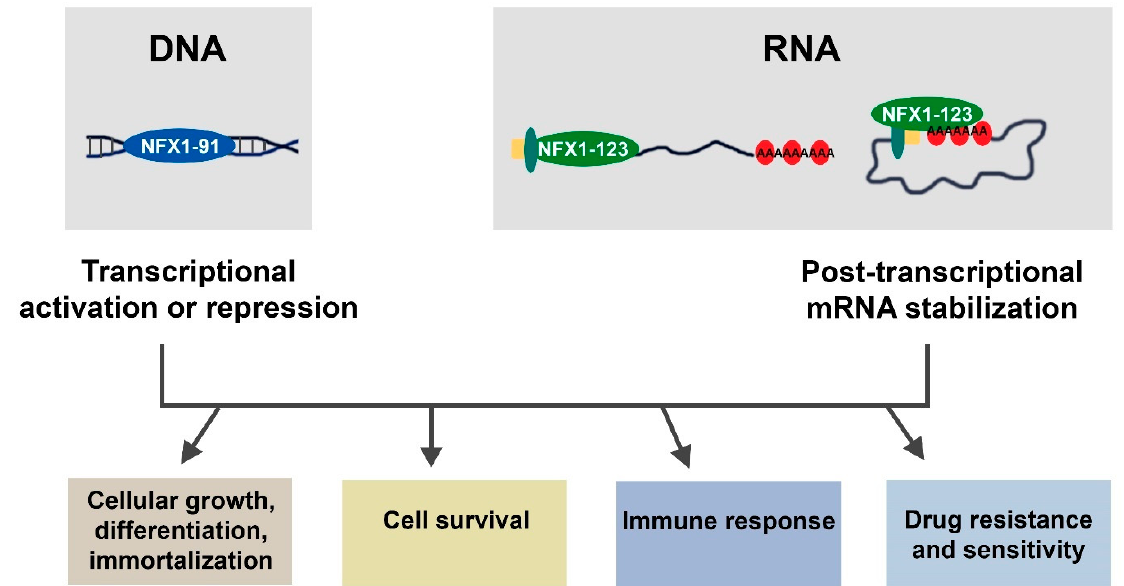
Figure 2. Regulation of gene expression by NFX1. Model of NFX1 (NFX1-91 and NFX1-123) mediated gene regulation. NFX1-91 binds to DNA to regulate gene expression either through transcriptional repression or activation. NFX1-123 binds to RNA to regulate gene expression through post-transcriptional regulation. NFX1-123 also interacts with other RNA binding and processing proteins, including cap-binding proteins (shown in yellow and teal) and cytoplasmic poly(A) binding proteins (shown in red). The cellular pathways affected by NFX1 are shown.